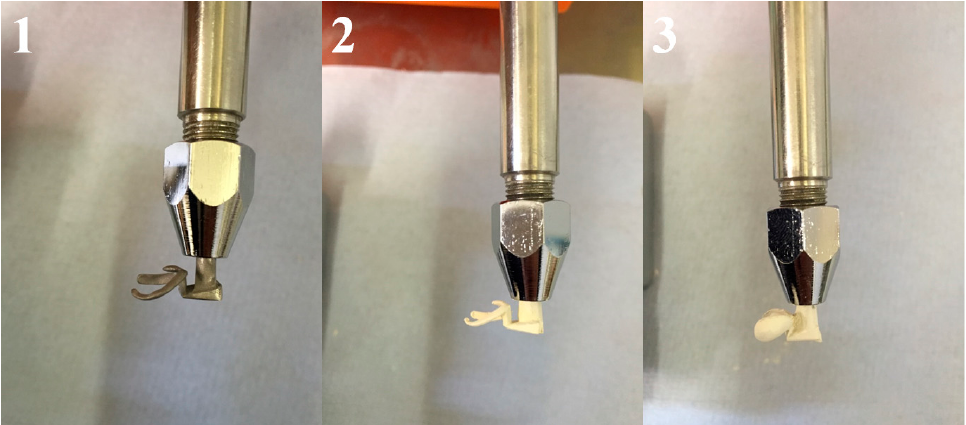
Figure 4. ( 1 ) Circumferential Co-Cr clasp, ( 2 ) circumferential PEEK clasp, and ( 3 ) circumferential PEEK clasp. PEEK